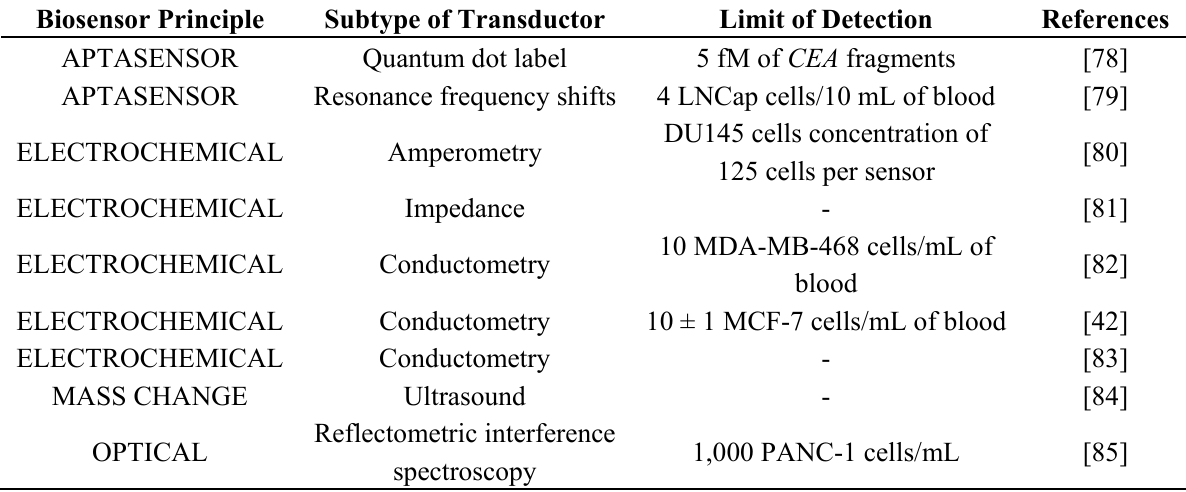
Table 2. Sensors for CTCs